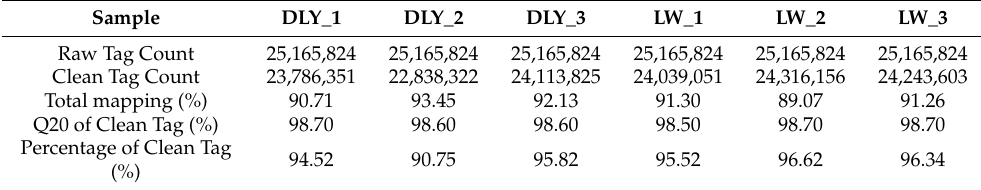
Table 2. Statistics of cDNA libraries of miRNA of Longissimus dorsi muscle samples from LW and DLY